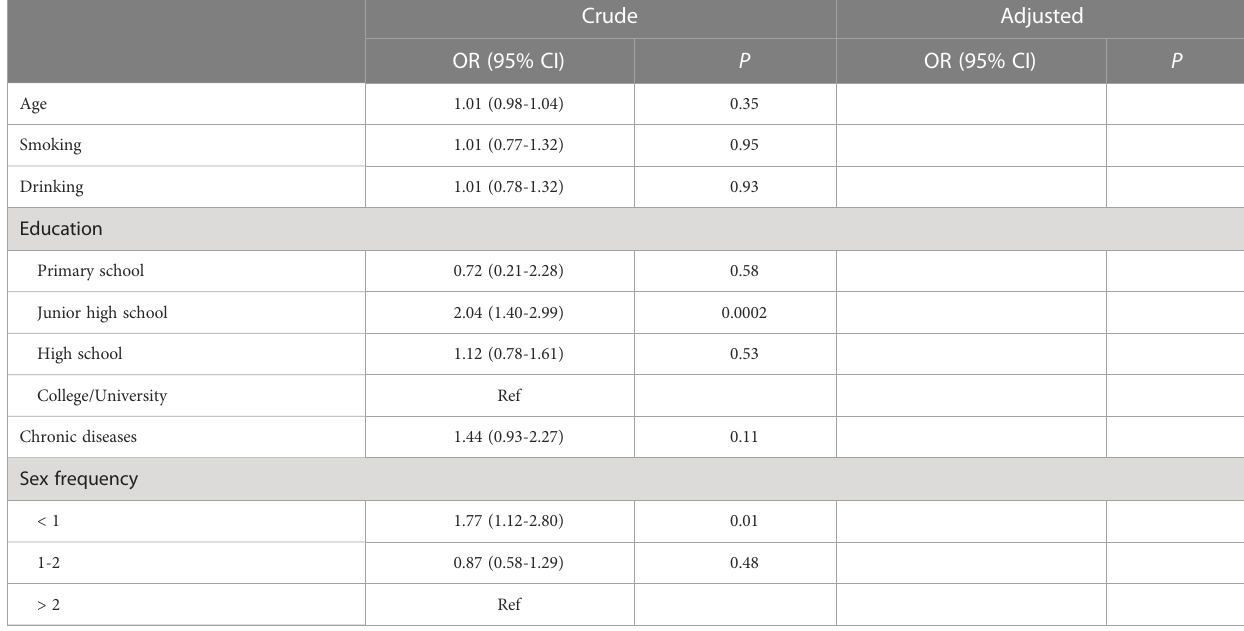
TABLE 3 Logistic regression analyses for ED and BMI, education and sex